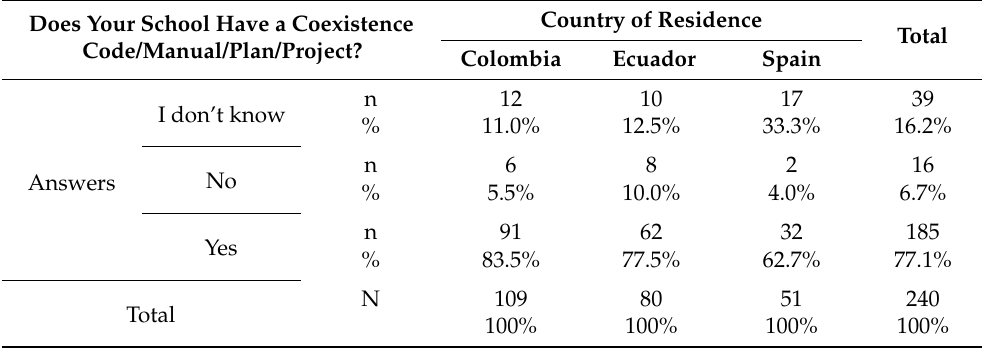
Table 1. Cross categories of the variable “Does your educational center have a Coexistence Plan” and the variable “Country of Residence”.